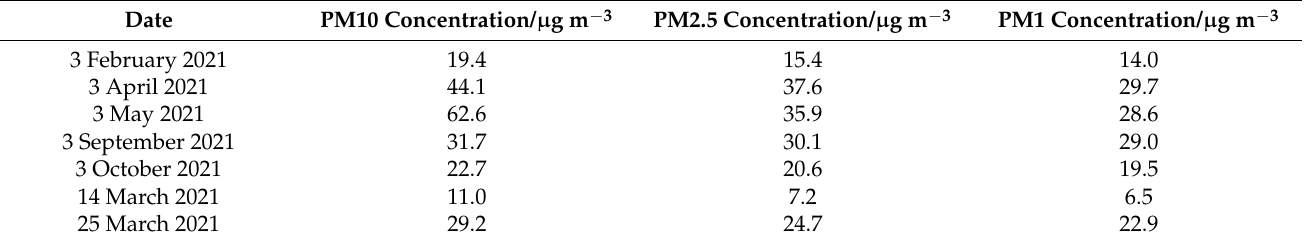
Table 5. The PM10, PM2.5, and PM1 average daily concentrations for the sampling site at the Deposition .